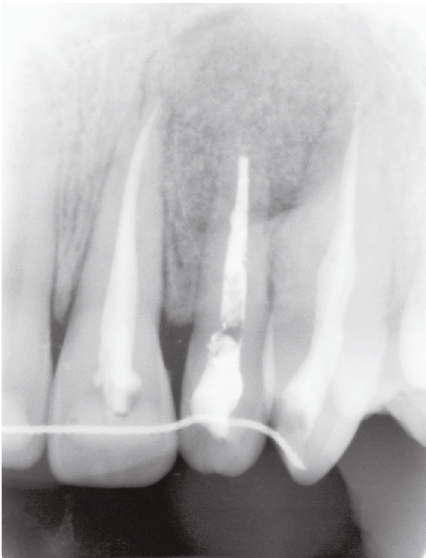
Figure 12: Healing after 3 months, clinical situation.